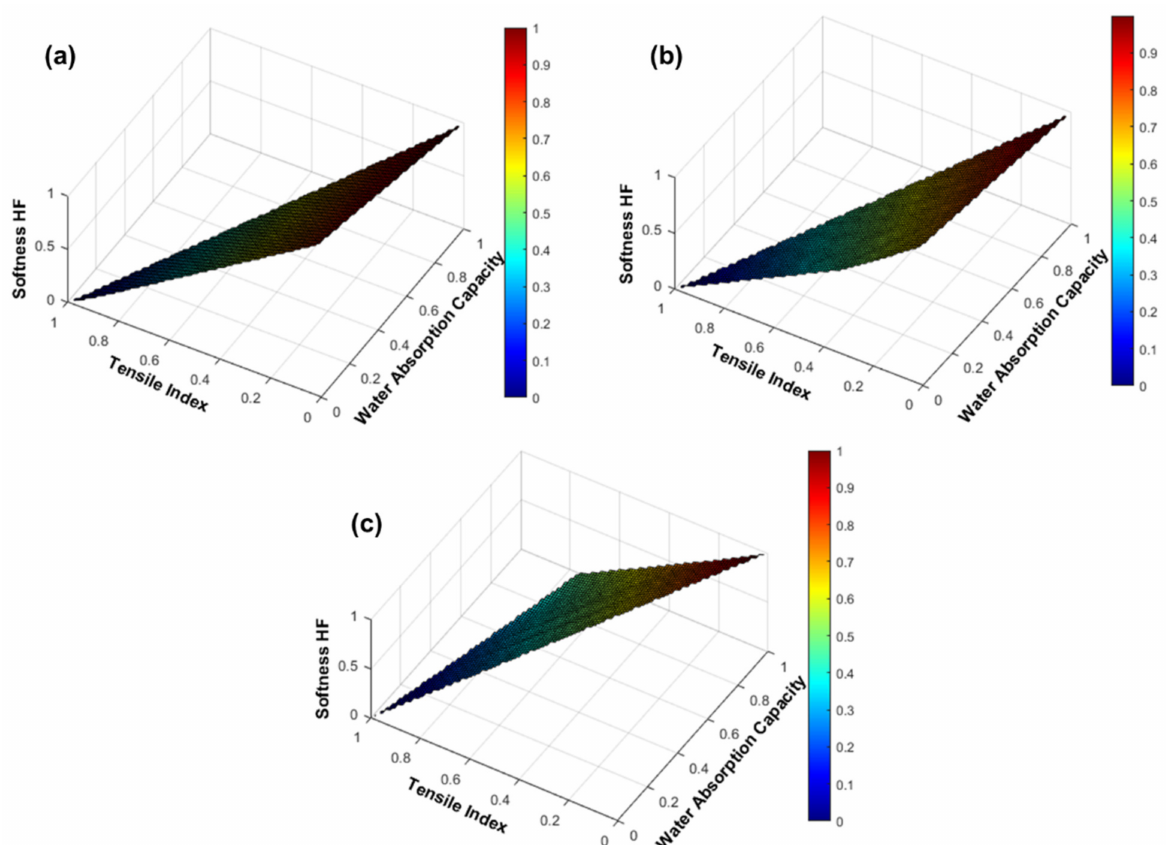
Figure 12. Evolution of the end-use tissue properties of softness HF, tensile index and water absorption capacity with the incorporation of CBA ( a ), CMF ( b ) and softwood fibers ( c ) in formulations with 100% eucalyptus fibers. All variables were normalized to present the same scale